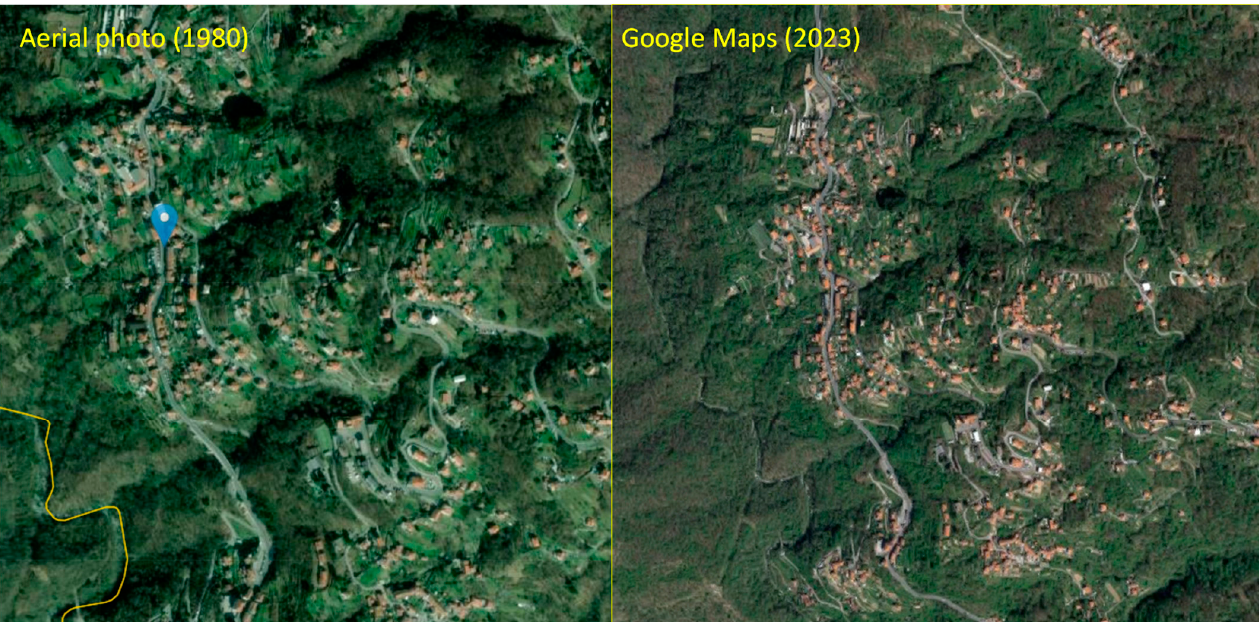
Figure 9. Comparison between the aerial photo from Geoportale (1980) and Google Maps view (2023).